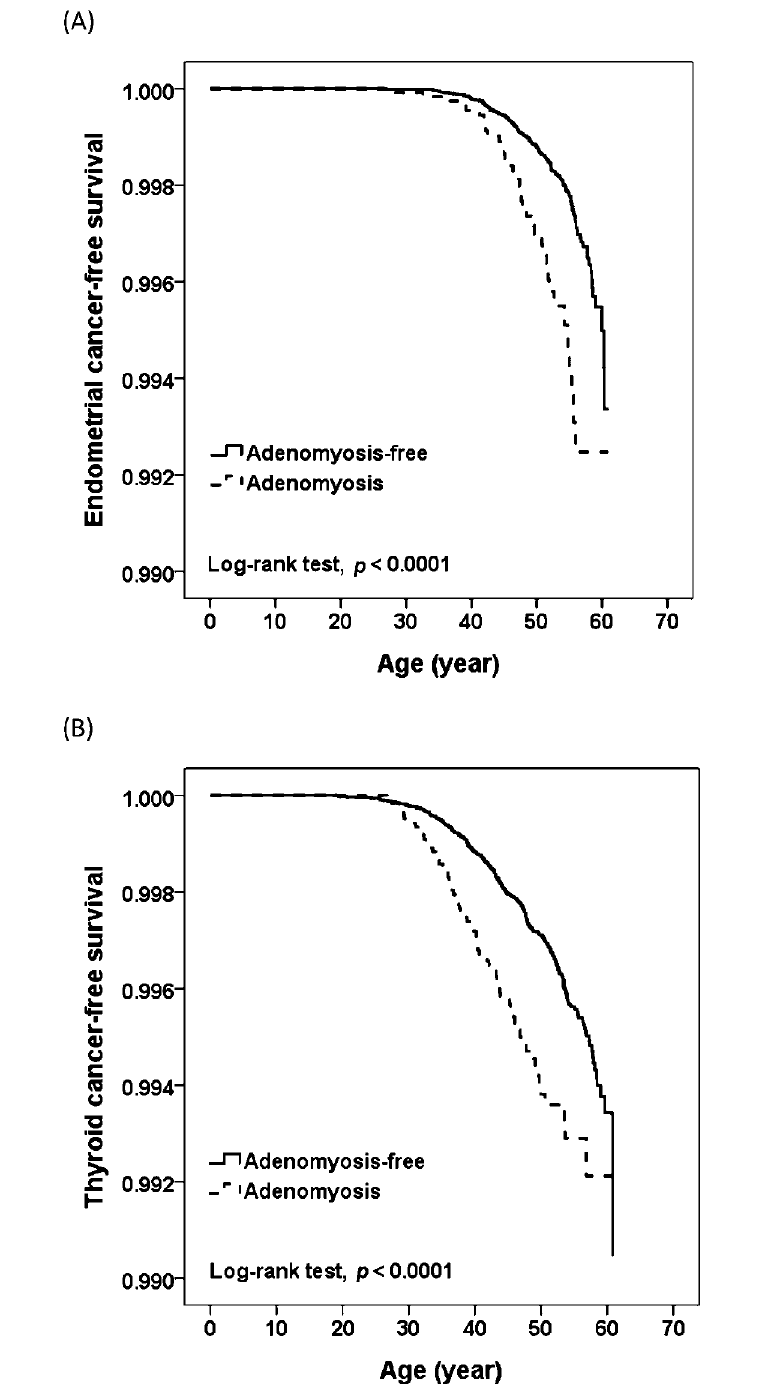
Fig 1. Cancer-free survival (CFS) curves in adenomyosis and adenomyosis-free cohorts. (A) CFS curves for endometrial cancer. (B) CFS curves for thyroid cancer.), for both endometrial and thyroid cancers, the CFS curve of the adenomyosis cohort significantly deviated from that of the adenomyosis-free cohort (both p < 0.001).